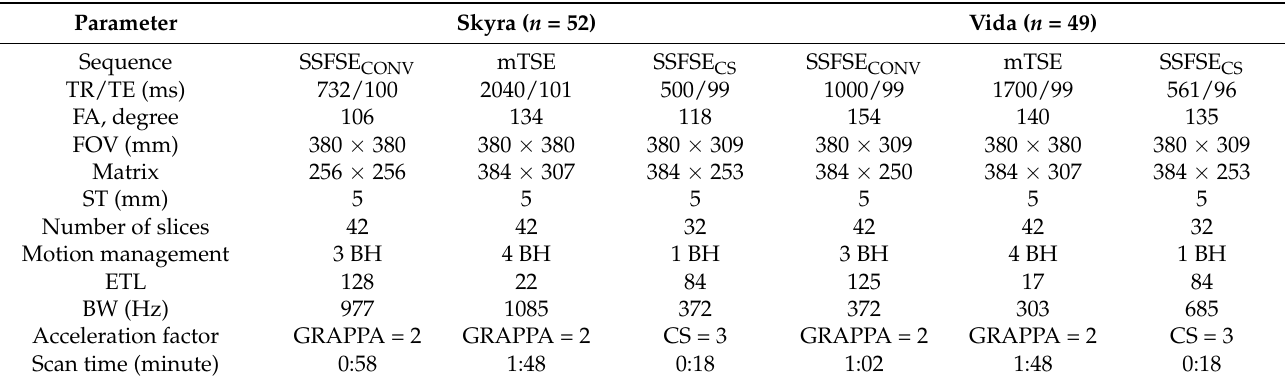
Table 1. Table 1. Acquisition parameters of three T2-weighted